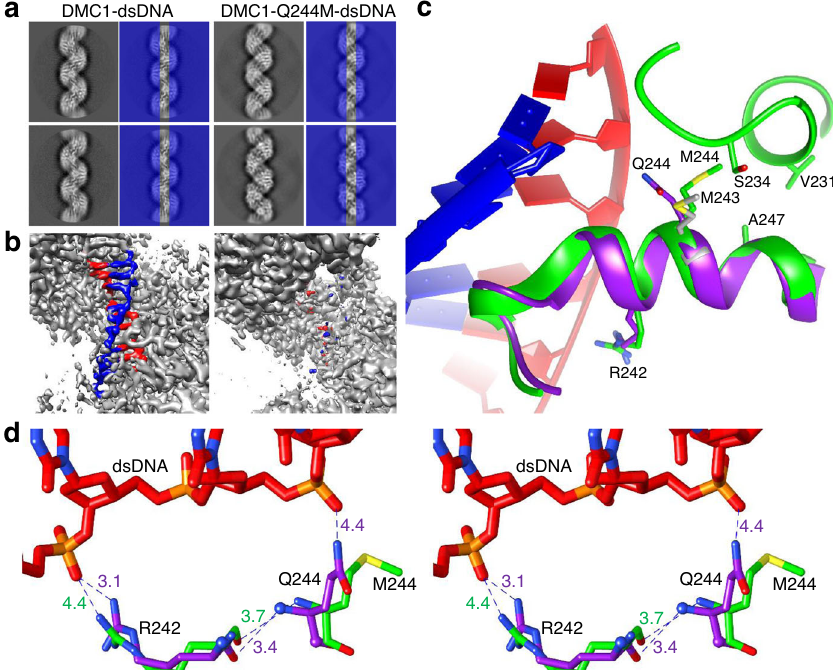
Fig. 2 Structural comparison between the postsynaptic fi laments of DMC1 and DMC1-Q244M with homologous dsDNA. a Examples of 2D class average showing DNA in the central axis (highlighted by covering the two sides by blue rectangles with 50% transparency) of the DMC1 fi laments but not the DMC1-Q244M fi laments. b Three-dimensional cryo-EM density maps showing that DNA densities (colored in red and blue) can be clearly observed in the DMC1-WT fi laments but only residual density can be detected in the DMC1-Q244M fi laments. c Superposition of the two structures, showing that the polar sidechain of Gln244 in DMC1 (purple) points toward DNA, whereas that of hydrophobic Met244 in DMC1-Q244M (green) points away from DNA and toward CH groups of nearby residues. For comparison, Met243 (gray) in RAD51 postsynaptic complex is also shown. d Stereo view of the relationship between the sidechains of the Gln244-Arg242 pair and the backbone of dsDNA in the postsynaptic fi laments of DMC1-WT (purple) and DMC1-Q244M (green). Relevant interatomic distances are shown in